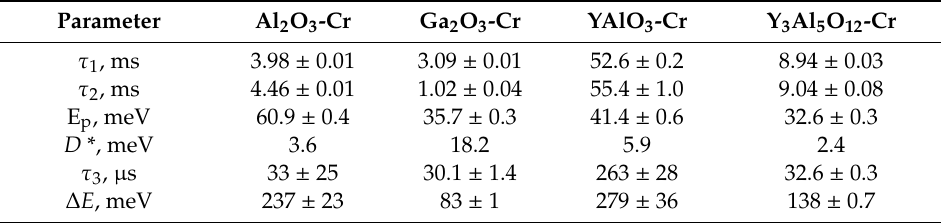
Figure 8. Temperature dependence of the luminescence decay time constant of Cr 3+ emission in Al 2 O 3 -Cr ( a ), Ga 2 O 3 -Cr ( b ), YAlO 3 -Cr ( c ), and Y 3 Al 5 O 12 -Cr ( d ). The curves show the best fit of Equation (5) to the experimental results with the fit parameters presented in Table 4. Table 4. Parameters of fits obtained from the temperature dependence of the luminescence decay time constant (Equation (5)) for Cr-doped